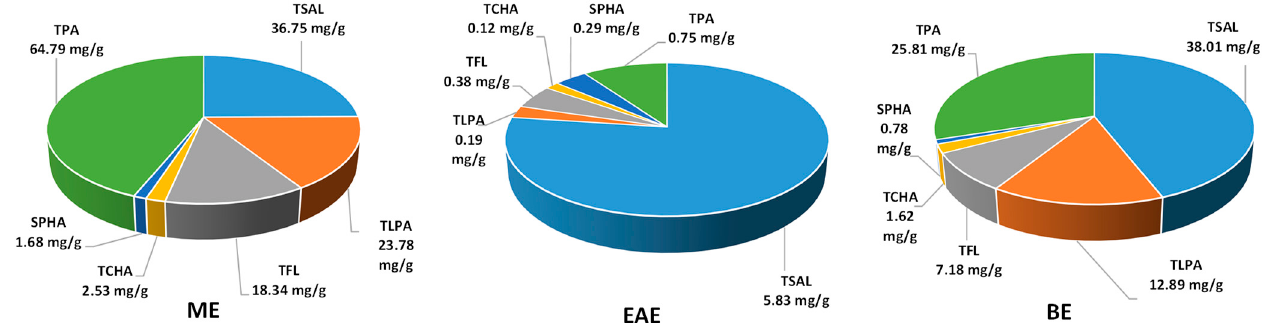
Figure 2. Recovery of polyphenols from the leaves with ME, EAE, and BE, expressed per leaf dw. TPA: total proanthocyanidin content ( n -butanol/HCl assay); TSAL: total content of salicylates (HPLC); TLPA: total content of proanthocyanidins (HPLC); TFL: total content of flavonoids (HPLC); TCHA: total content of chlorogenic acid isomers (HPLC); SPHA: total content of simple hydroxybenzoic and hydroxycinnamic acids (HPLC).